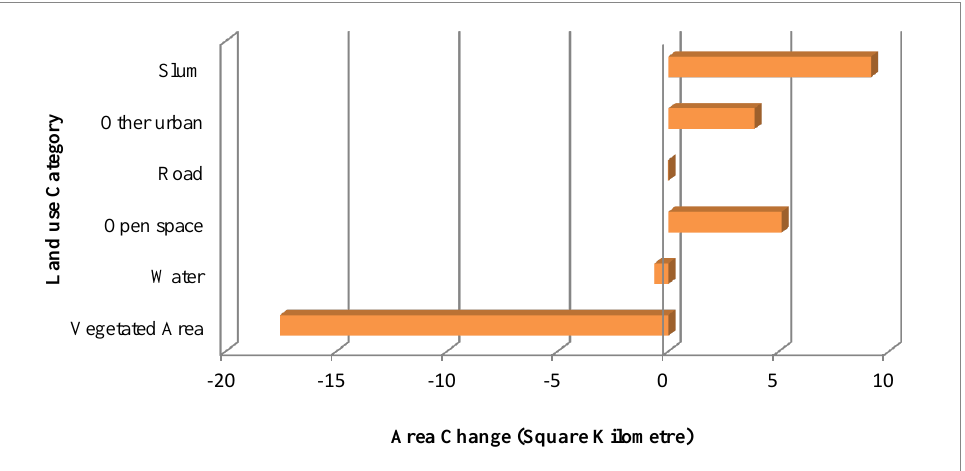
Figure 7. Area change of land use categories in the research area from 2009 to 2015.